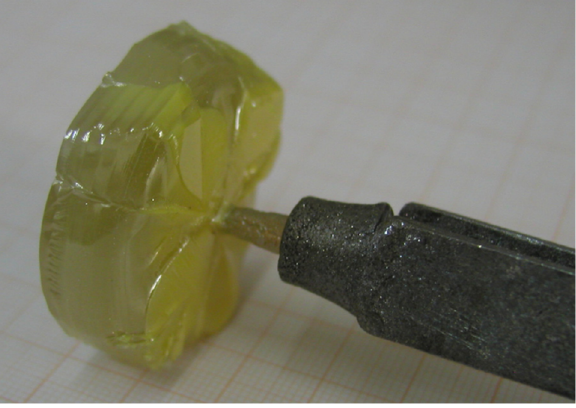
Figure 2. The photograph of as-grown (Na 0.5 Bi 0.5 )TiO 3 -BaTiO 3 (NBT-BT) crystal. Reprinted with permission from [24]. Copyright 2008 AIP Publishing